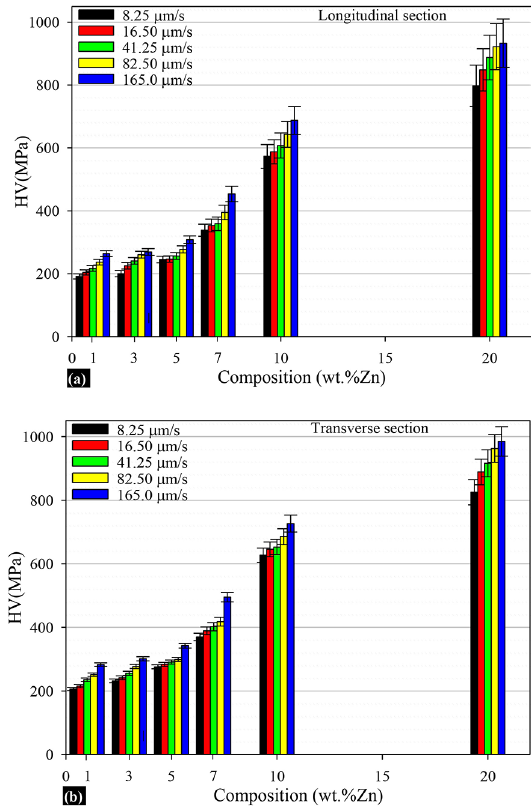
Figure 7. The variation of microhardness with composition for solid phase obtained with different growth velocities (a) Longitudinal section (b) Transverse